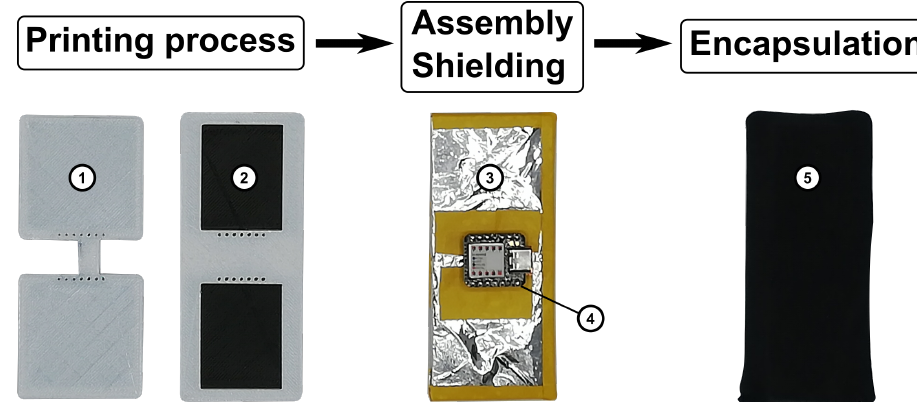
Figure 5. The sensor is composed of two flexible thermoplastic polyurethane materials; a non- conductive TPU filament (1) is used to print the substrate and encapsulant, and a conductive TPU filament (2) is used to print the capacitive plates. The sensor is assembled, shielded (3), and encapsulated in a stretchable fabric (5) to be implemented in a physical interface. A microcontroller unit (4) is integrated to measure